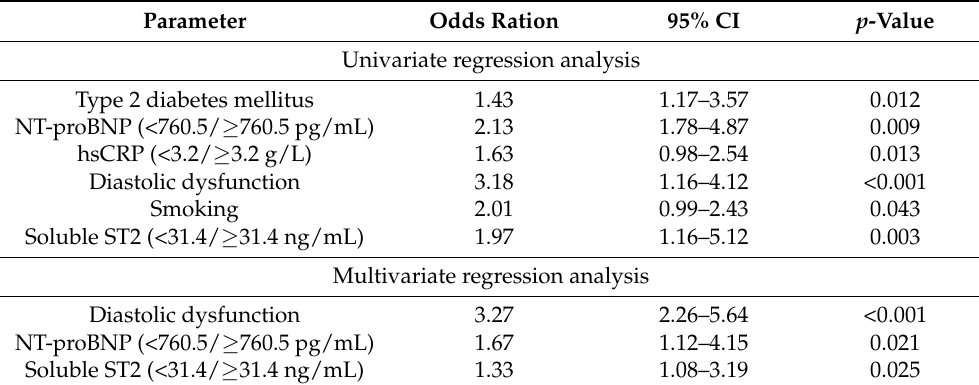
Table 4. Results of univariate and multivariate regression